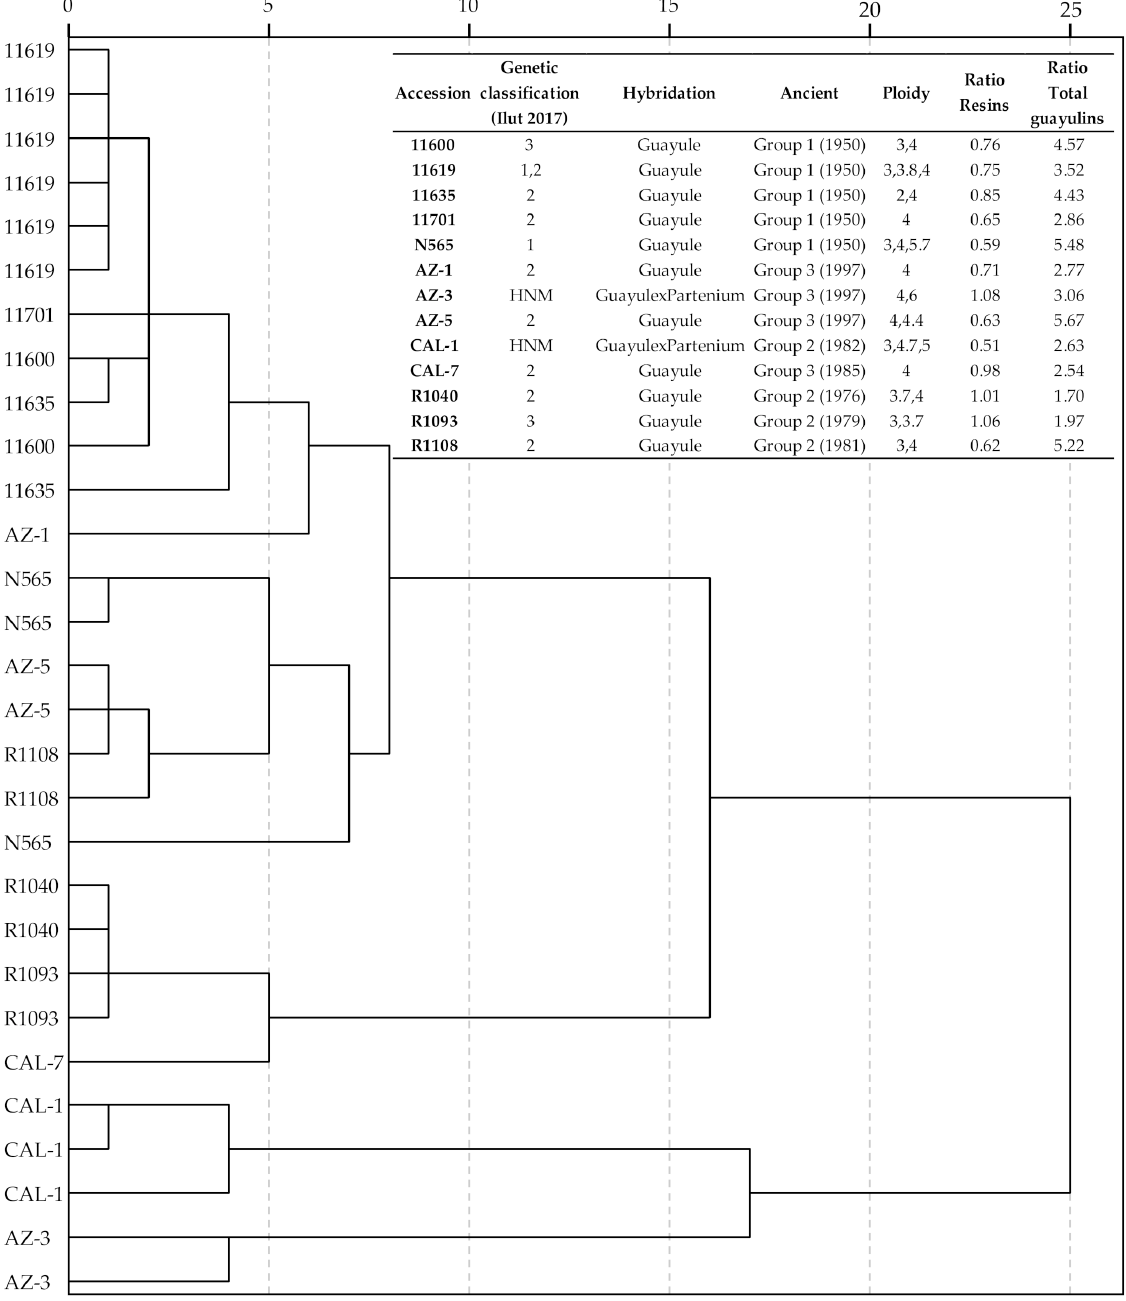
Figure 4. Relationship of resin and total guayulins content with accession ploidy and genetic origin according to Ilut et al. [16].